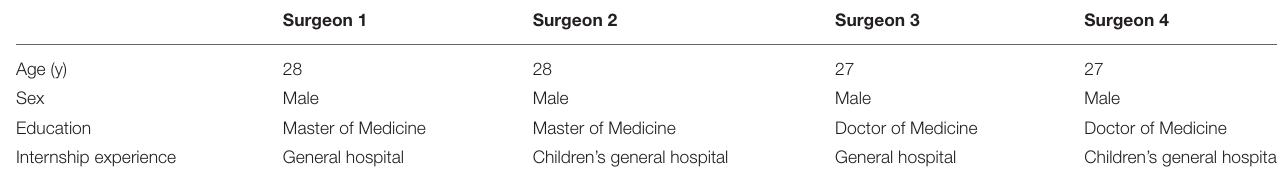
TABLE 2 | Surgeons